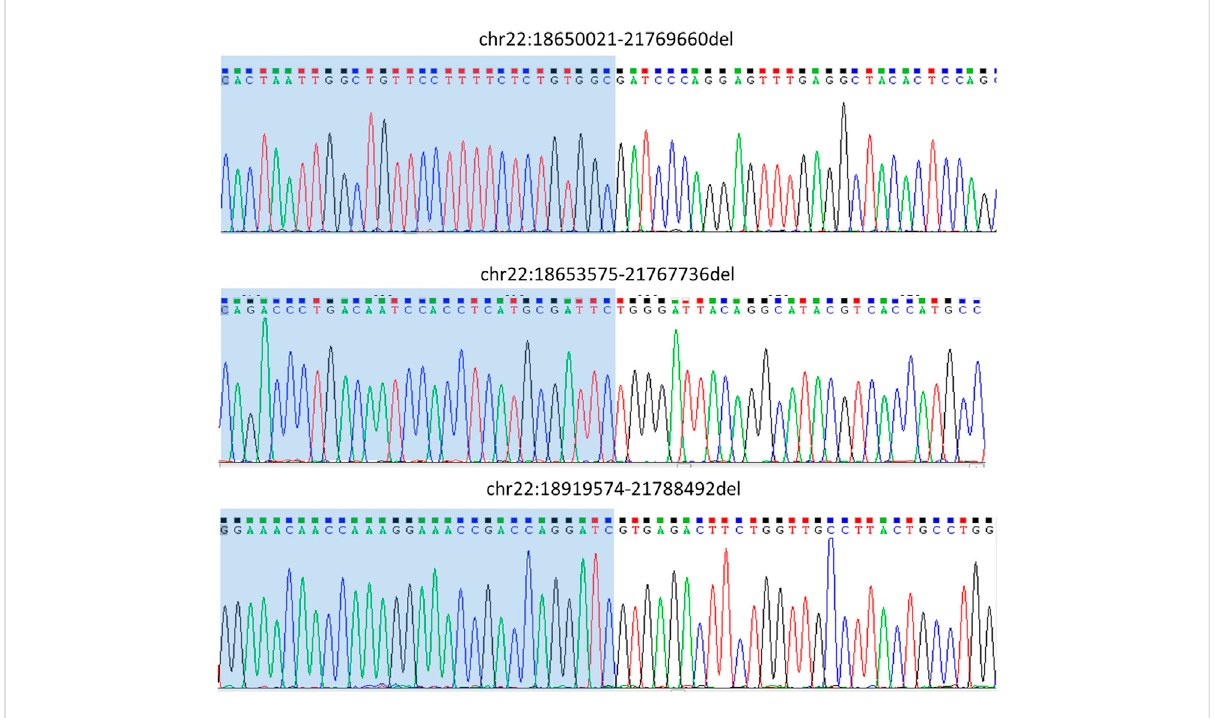
FIGURE 3 Variant validation by Sanger sequencing. Primers that were designed at both ends of the breakpoints were to perform PCR and Sanger sequencing. The Sanger sequencing results supported the Snif fl es analysis